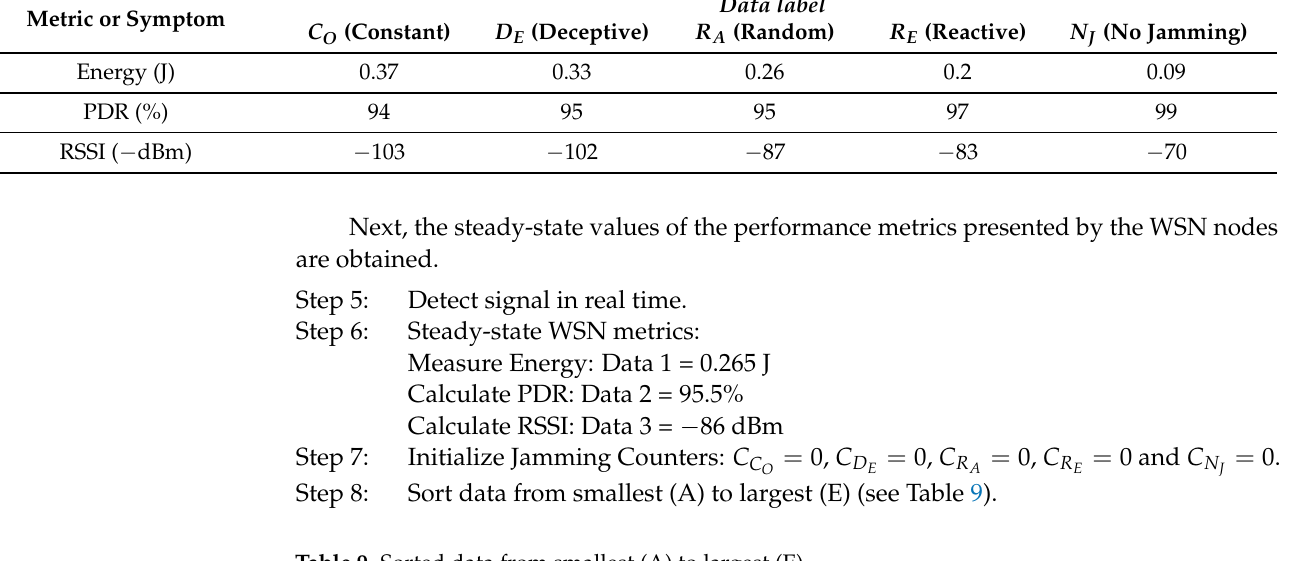
Table 9. Sorted data from smallest (A) to largest (E).